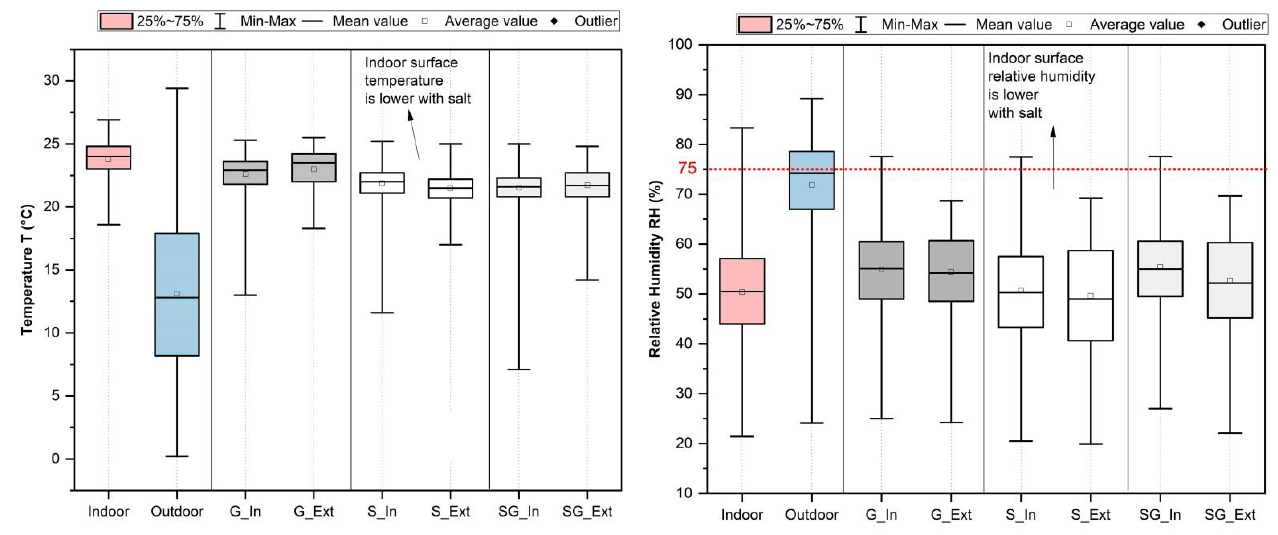
Figure 8. In situ measurements of relative humidity and temperature in Munich (red colour—indoor air temperature, blue colour—outdoor air temperature, grey colour—gypsum, white colour—salt, light grey colour—salt–gypsum, In — surface to interior, Ext—surface to exterior).